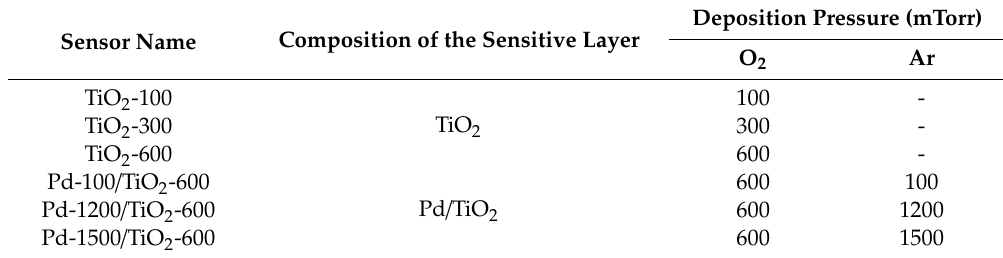
Table 1. Sensors and the pressure deposition of the sensitive films.